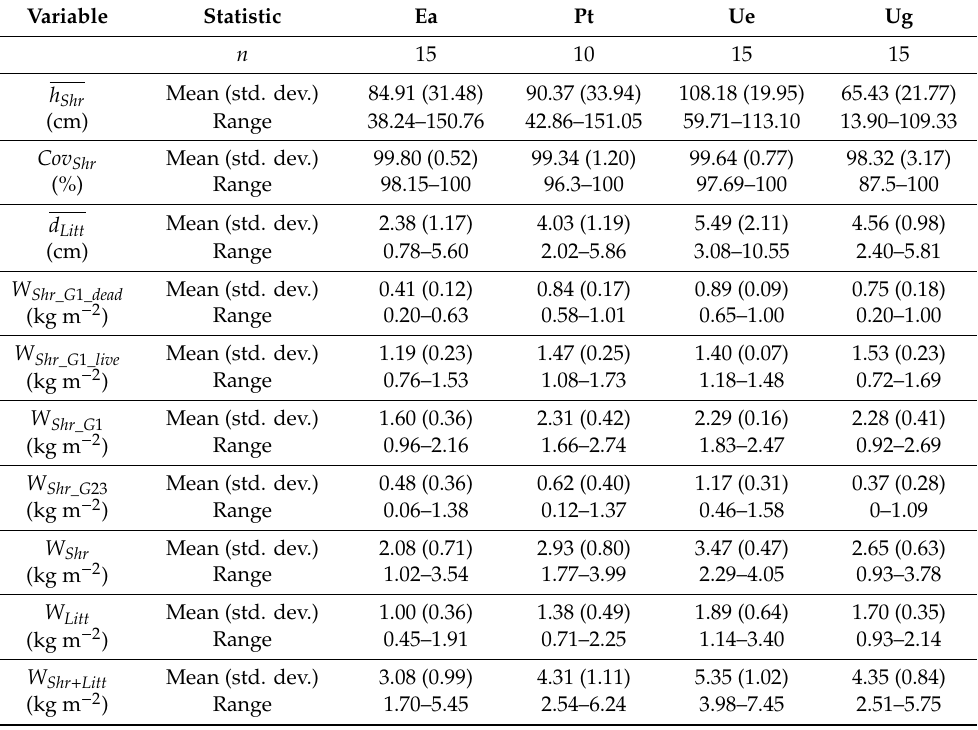
Table 2. Description of the main shrub and litter characteristics. Std. dev. is the standard deviation, n is the number of plots, h Shr is the mean shrub height, Cov Shr is the shrub cover, d Litt is the mean litter depth, W Shr_G 1_ dead is the dead fine shrub fuel load, W Shr_G 1_ live is the live fine shrub fuel load, W Shr_G 1 is the fine shrub fuel load, W Shr_G 23 is the coarse shrub fuel load, W Shr is the total shrub fuel load, W Litt is the litter fuel load, and W Shr + Litt is the shrub and litter fuel load.